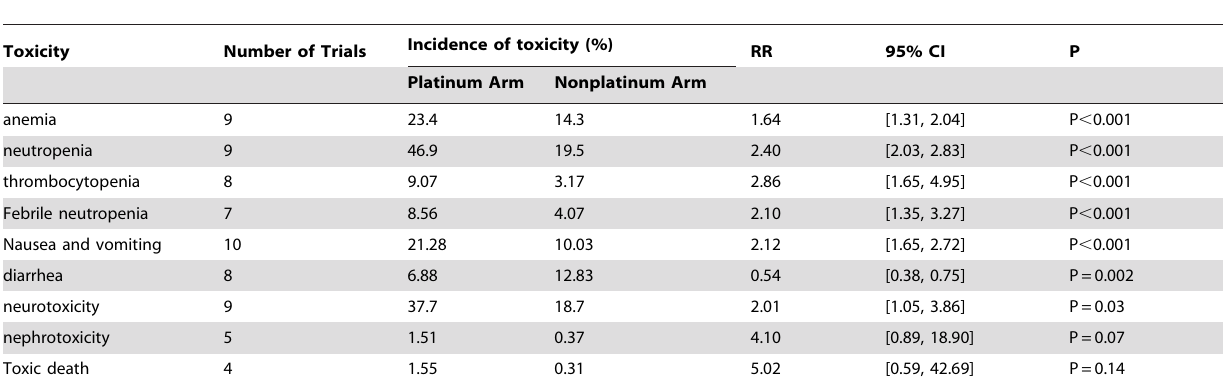
Table 2. Comparison of Toxicity Between Platinum Arms and Nonplatinum Arms with new-generation agents.